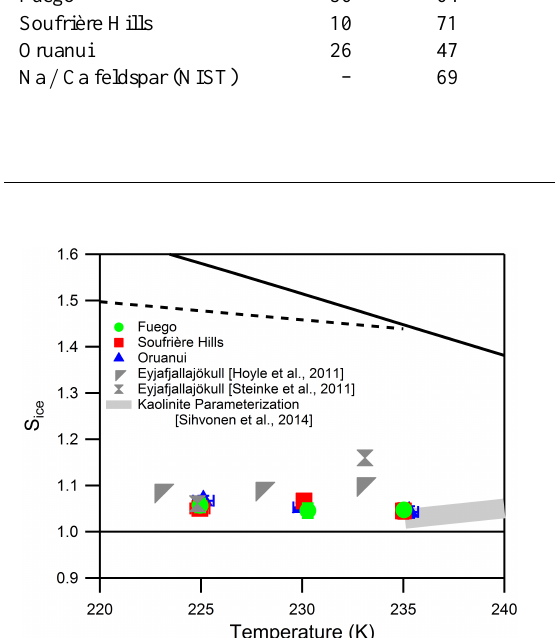
Figure 4. The onset S ice as a function of temperature for ice nucle- ation on volcanic ash samples. The thick and thin solid lines refer to water and ice saturation respectively. The dashed line represents the S ice values for homogeneous nucleation of an aqueous droplet (Koop et al., 2000). Also included are onset results from deposi- tional ice nucleation experiments on ash from the 2010 Eyjafjalla- jökull eruption (Hoyle et al., 2011; Steinke et al., 2011) and a pa- rameterization for depositional ice nucleation on KGa-1b (Sihvonen et al.,